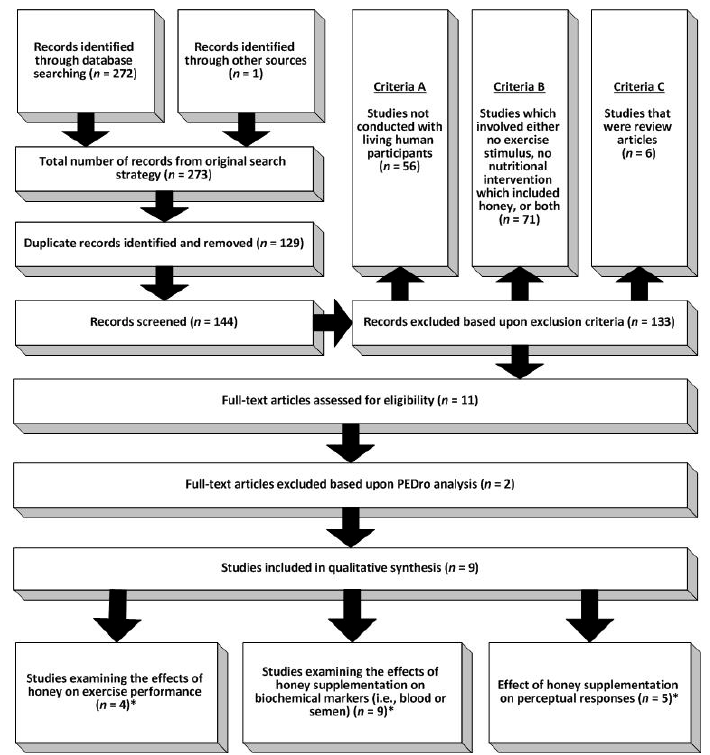
Figure 1. Selection process for articles included in the systematic review. * denotes that some studies examined multiple constructs, thus are included in more than one category.